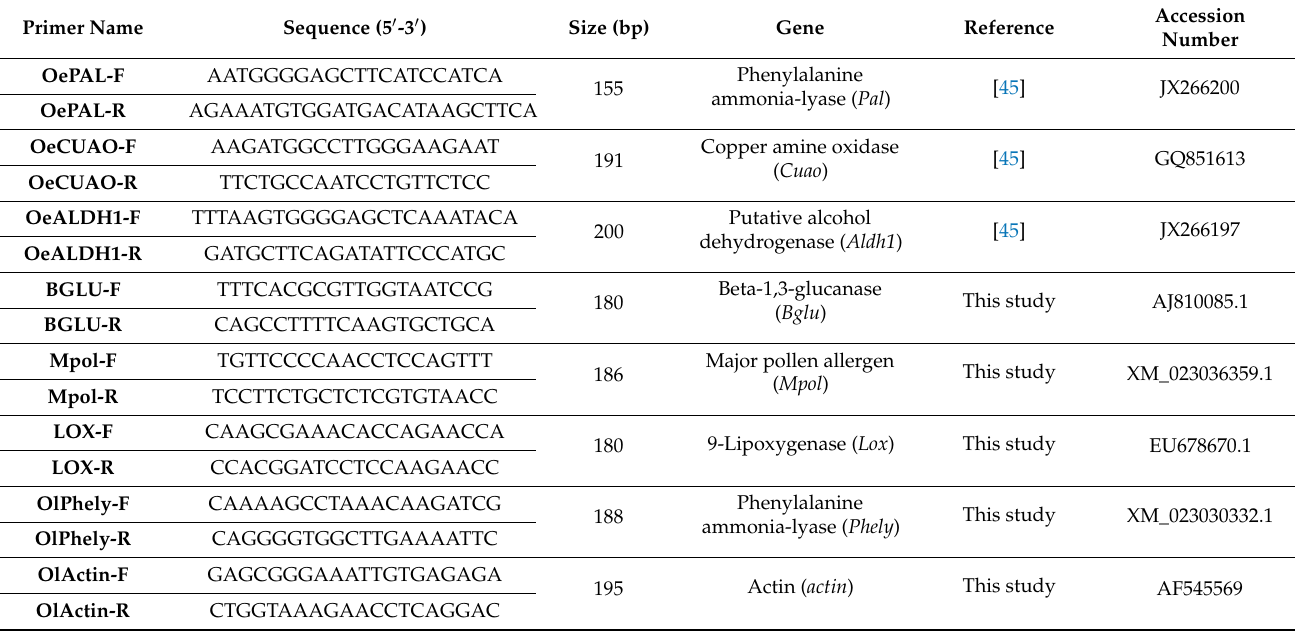
Table 2. Primer sequences used for gene expression analysis in real-time quantitative polymerase chain reaction (RT- qPCR)